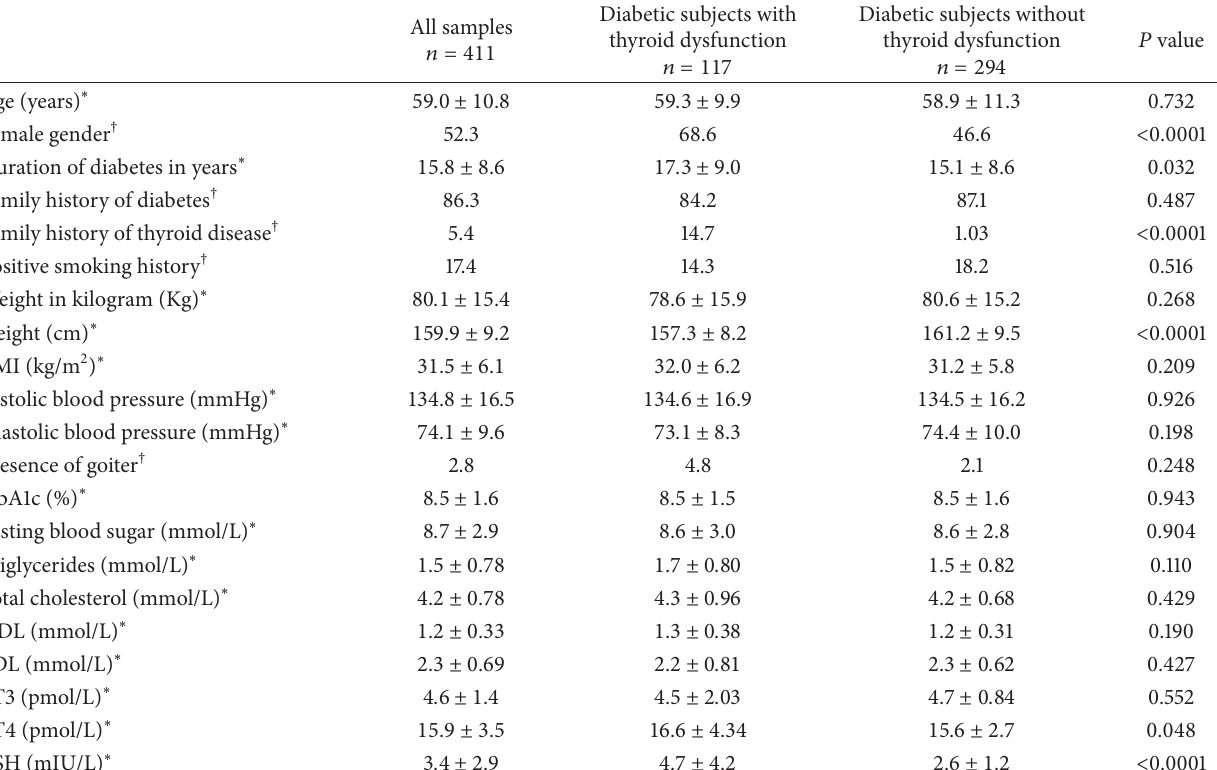
Table 1: Baseline characteristics of study sample for all subjects with or without thyroid dysfunction among Type 2 diabetic patients aged > 25 years.